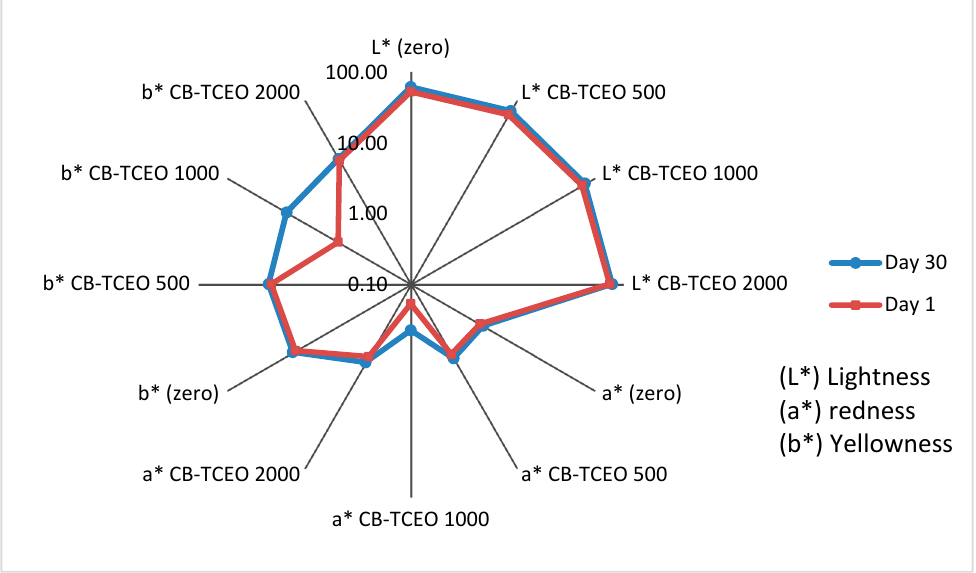
Figure 6. Effect of CB-TCEO on the color parameters of the Tilapia sample. L* = Lightness; a* = redness; b* = yellowness (CIELab, color coordinates).